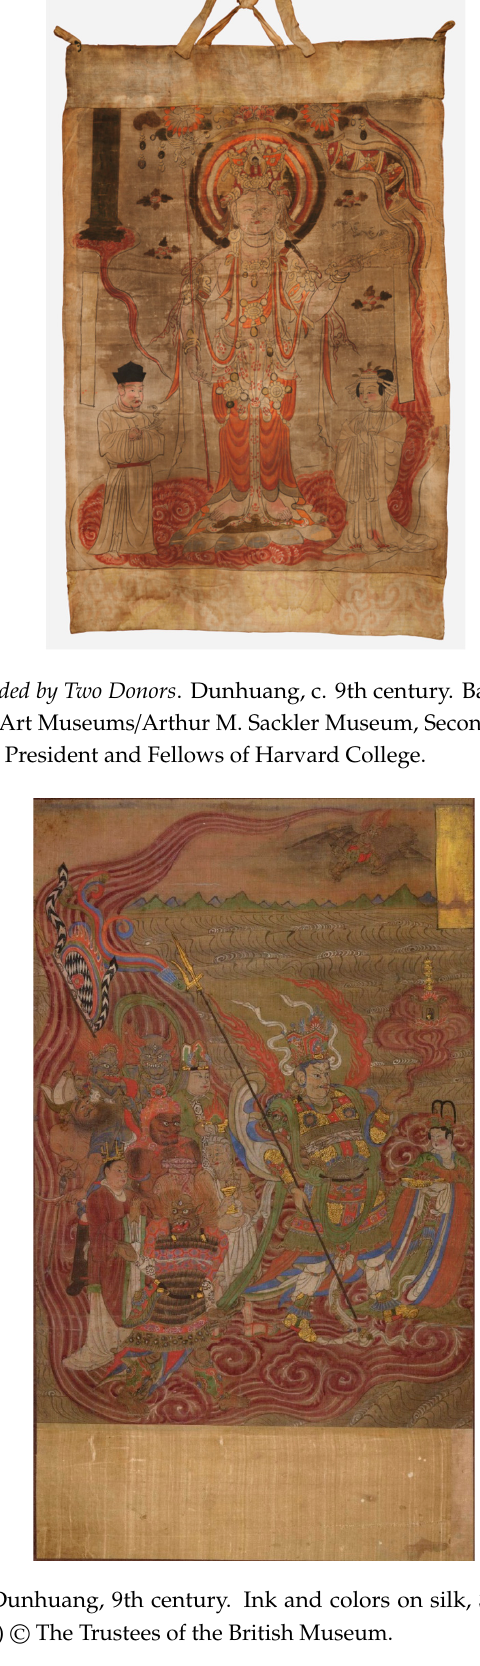
Figure 14. Vai ś rava ṇ a . Dunhuang, 9th century . Ink and colors on silk, 37.6 × 26.6 cm . The British Figure 14. Vai´sravan. a . Dunhuang, 9th century. Ink and colors on silk, 37.6 × 26.6 cm. The British Museum (1919,0101,0.45) © The Trustees of the British Museum. Museum (1919,0101,0.45) © The Trustees of the British